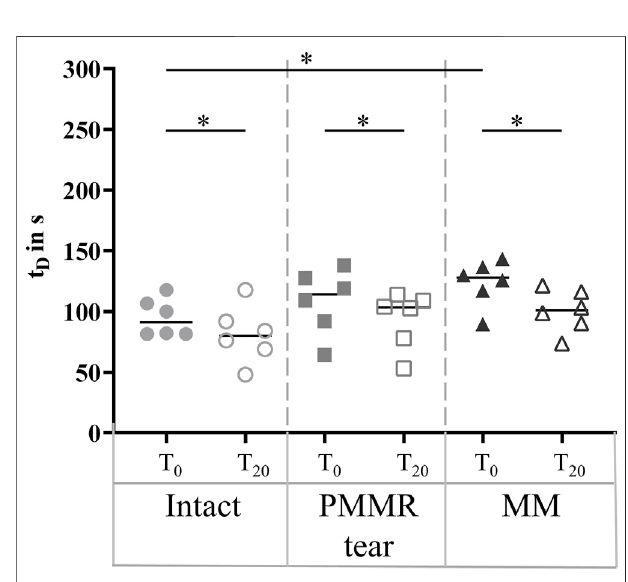
FIGURE 6 | Scatter plots (median with individual values) of the damping time (t D ) of the pendulum motion under swing phase conditions with the intact meniscus state (symbol shape: circles), with a posterior medial meniscus root tear (PMMR tear) (symbol shape: squares) and after medial meniscectomy (MM) (symbol shape: rectangles). The tests were performed directly after loading the joints with 250 N (T 0 , fi lled symbols) and after resting under the axial load for 20 min (T 20 , un fi lled symbols). Non-parametric statistical analyses: n (cid:1) 6; * p <